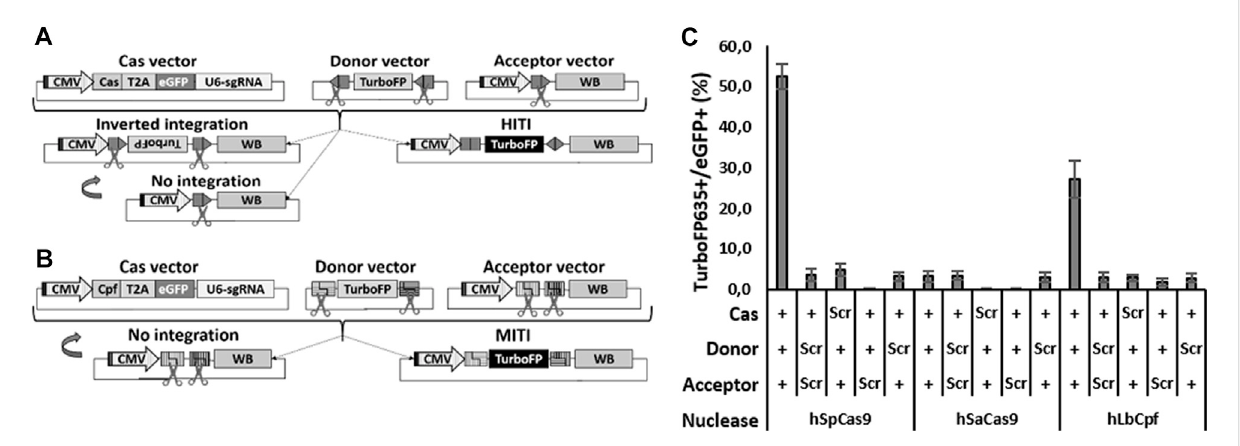
FIGURE 1 Ef fi cient HITI and MITI with human sgRNAs in N2a cells. (A, B) Schematic representation of the vectors for in vitro HITI (A) and MITI (B) . The TurboFP635 sequence is indicated in light gray when the gene is not expressed, while it is indicated in black when the protein is expressed. CMV: cytomegalovirus ubiquitouspromoter; T2A, T2A peptide; U6-sgRNA, sgRNA expressioncassette; WB, WPRE-BGHpA. (C) Cyto fl uorimetric quanti fi cation of HITI and MITI. Scr: scramble plasmid; RFP: TurboFP635 expressing vector. Shown are mean ± sem, n = 3 experimental